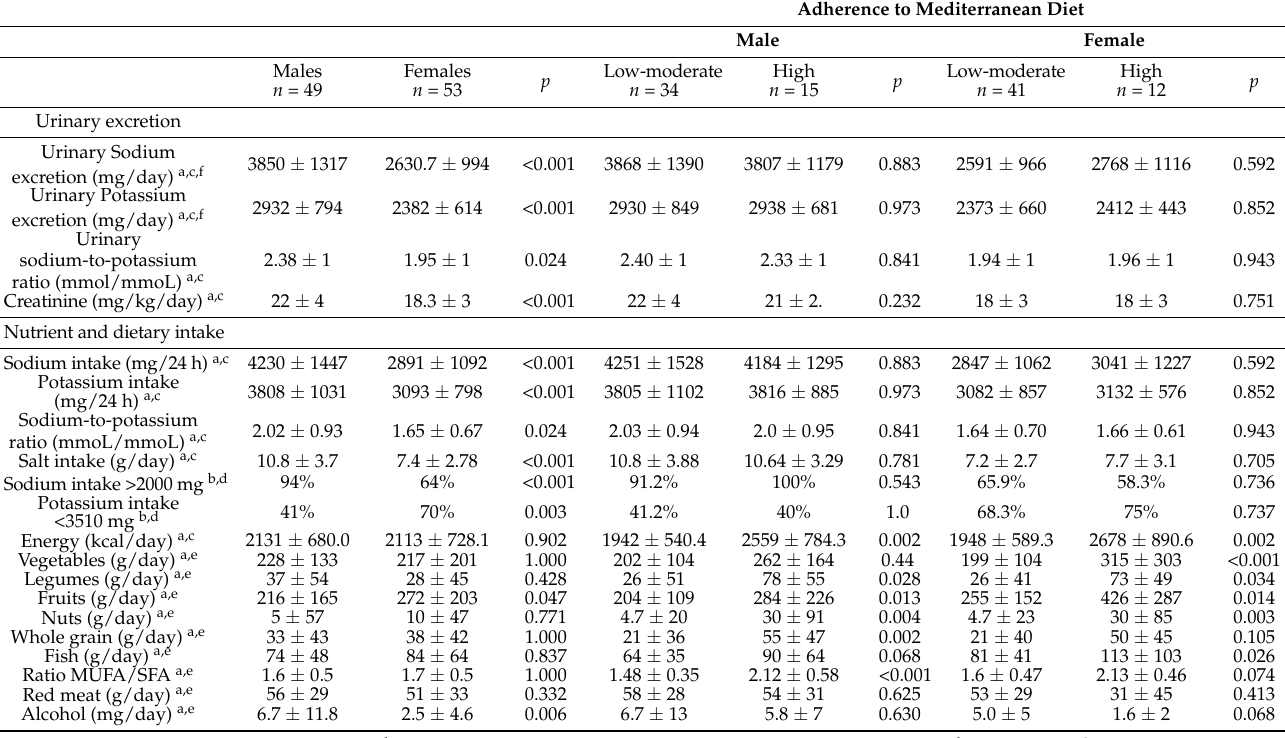
Table 2. Urinary excretion and nutrient/food intake of participants according to sex and adherence to Mediterranean Diet.